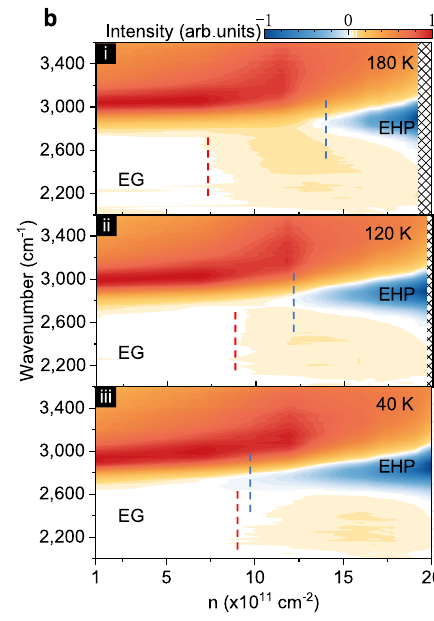
Fig. 3 | Strong correlated EHP phases in BP. a Spectral phase diagram in tem- peratureande – hpairdensityspaceforcorrelatedelectron – holestates.Inthehigh- temperatureregime,threeregionsarede fi nedbythecharacteristicsofabsorption/ gain spectra, where EG, IM, and EHP denote the exciton gas (red), intermediate metal (green), electron – hole plasma (blue) phases, respectively. The boundaries